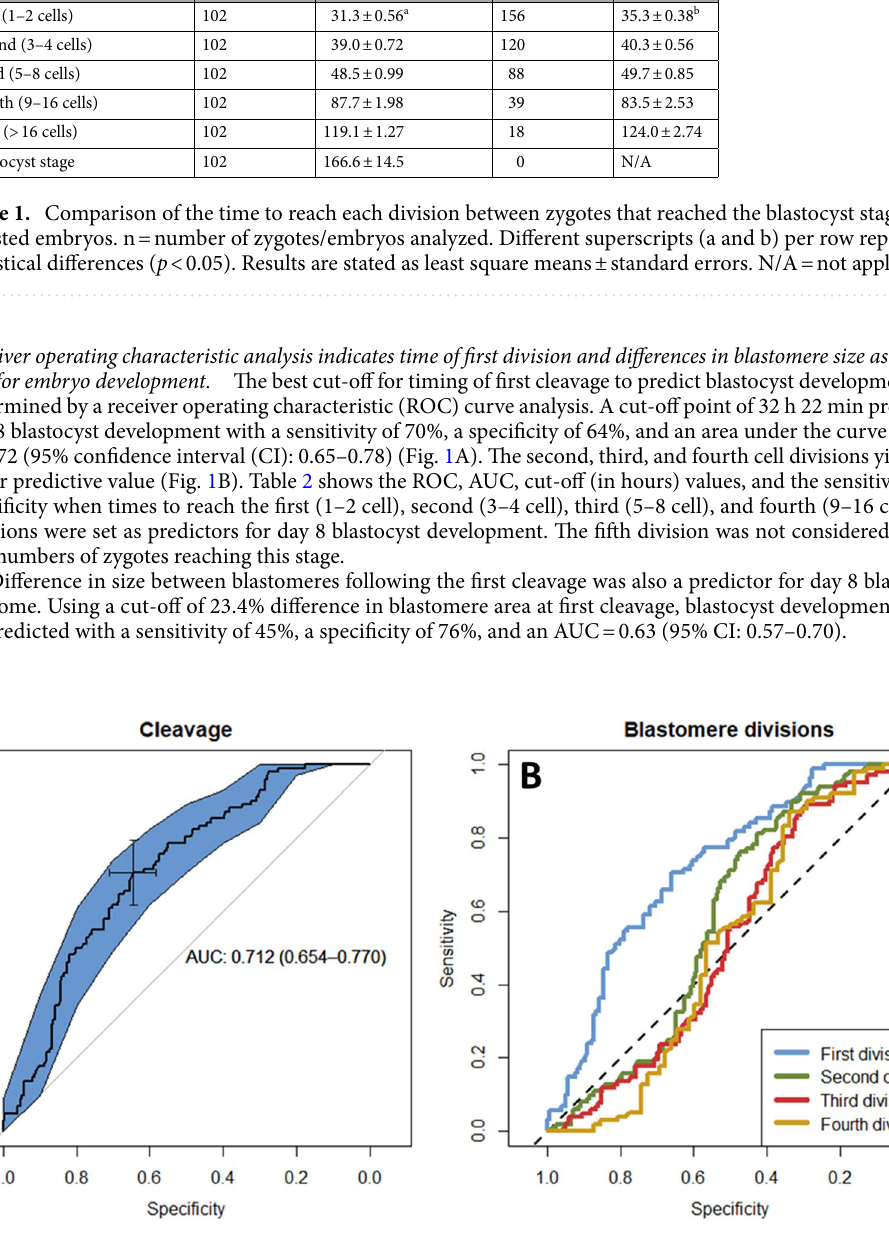
Figure 1. Receiver operating characteristics (ROC) curves with blastocyst development at day 8 post insemination as the classifier (blastocyst yes vs. blastocyst no). ( A ) ROC curve for timing of first division. ( B ) Comparison of different ROC curves for each division. AUC area under the curve.